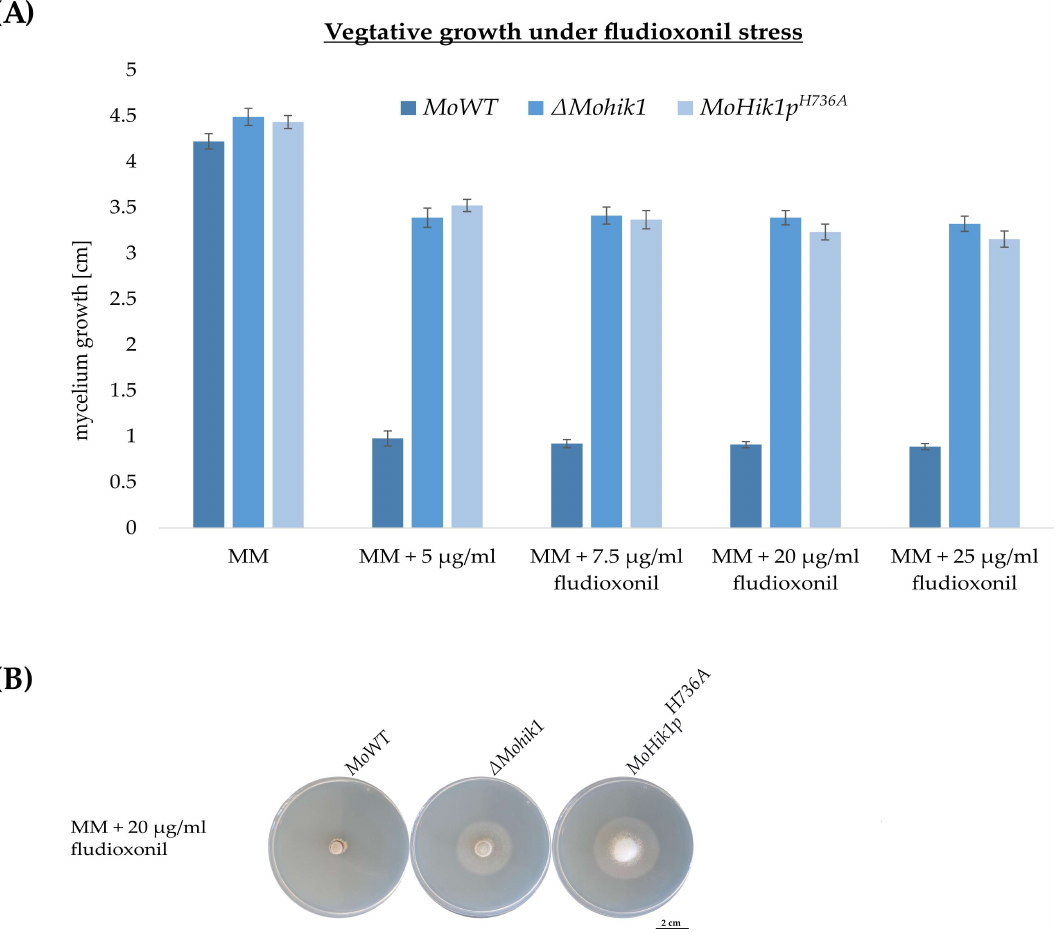
Figure 2. ( A ) Vegetative growth of Magnaporthe oryzae wild-type strain ( MoWT ), the loss-of-function mutant ∆ Mohik1 and the MoHik1p H736A mutant under fludioxonil stress. Mycelium growth was measured on MM supplemented with different concentrations of the fungicide fludioxonil. The experiment was conducted for 7 days at 26 ◦ C. ( B ) Pictures of the cultures grown for 7 days on MM + 20 µ